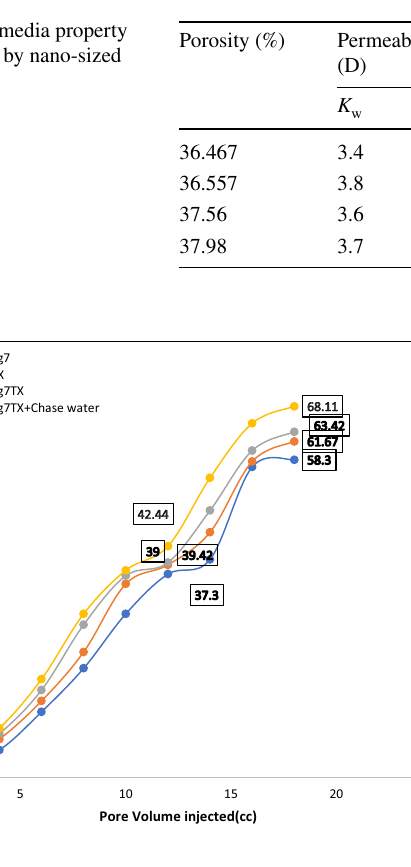
Fig. 6 Oil recovery (%) w.r.t pore volume injected (cc) for different nano-sized slugs of